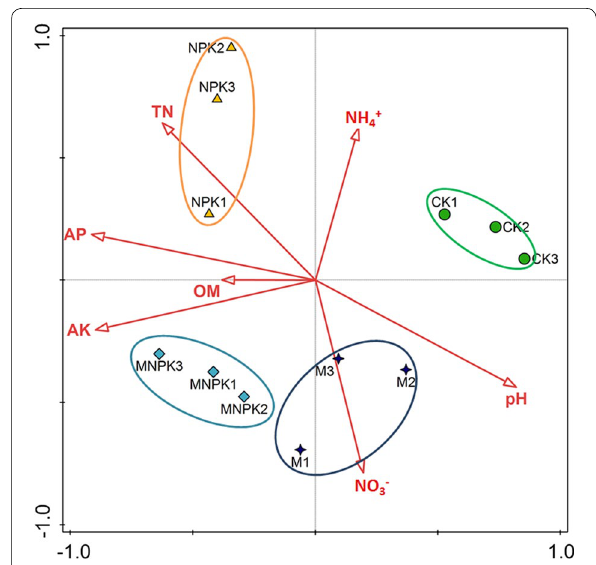
Fig. 3 Redundancy analysis of soil AMF communities and soil prop- erties. Soil factors indicated in red text include available phosphorus (AP), available potassium (AK), pH, soil concentration of NH 4 + (NH 4 + ), soil concentration of NO 3 − (NO 3 − ), total nitrogen (TN) and organic matter (OM). Treatment: (triangle) CK, no fertilizer; (circle) M, manure; (square) NPK, inorganic phosphorus, potassium and nitrogen ferti- lizer; (cross) MNPK, inorganic P, K and N fertilizer plus